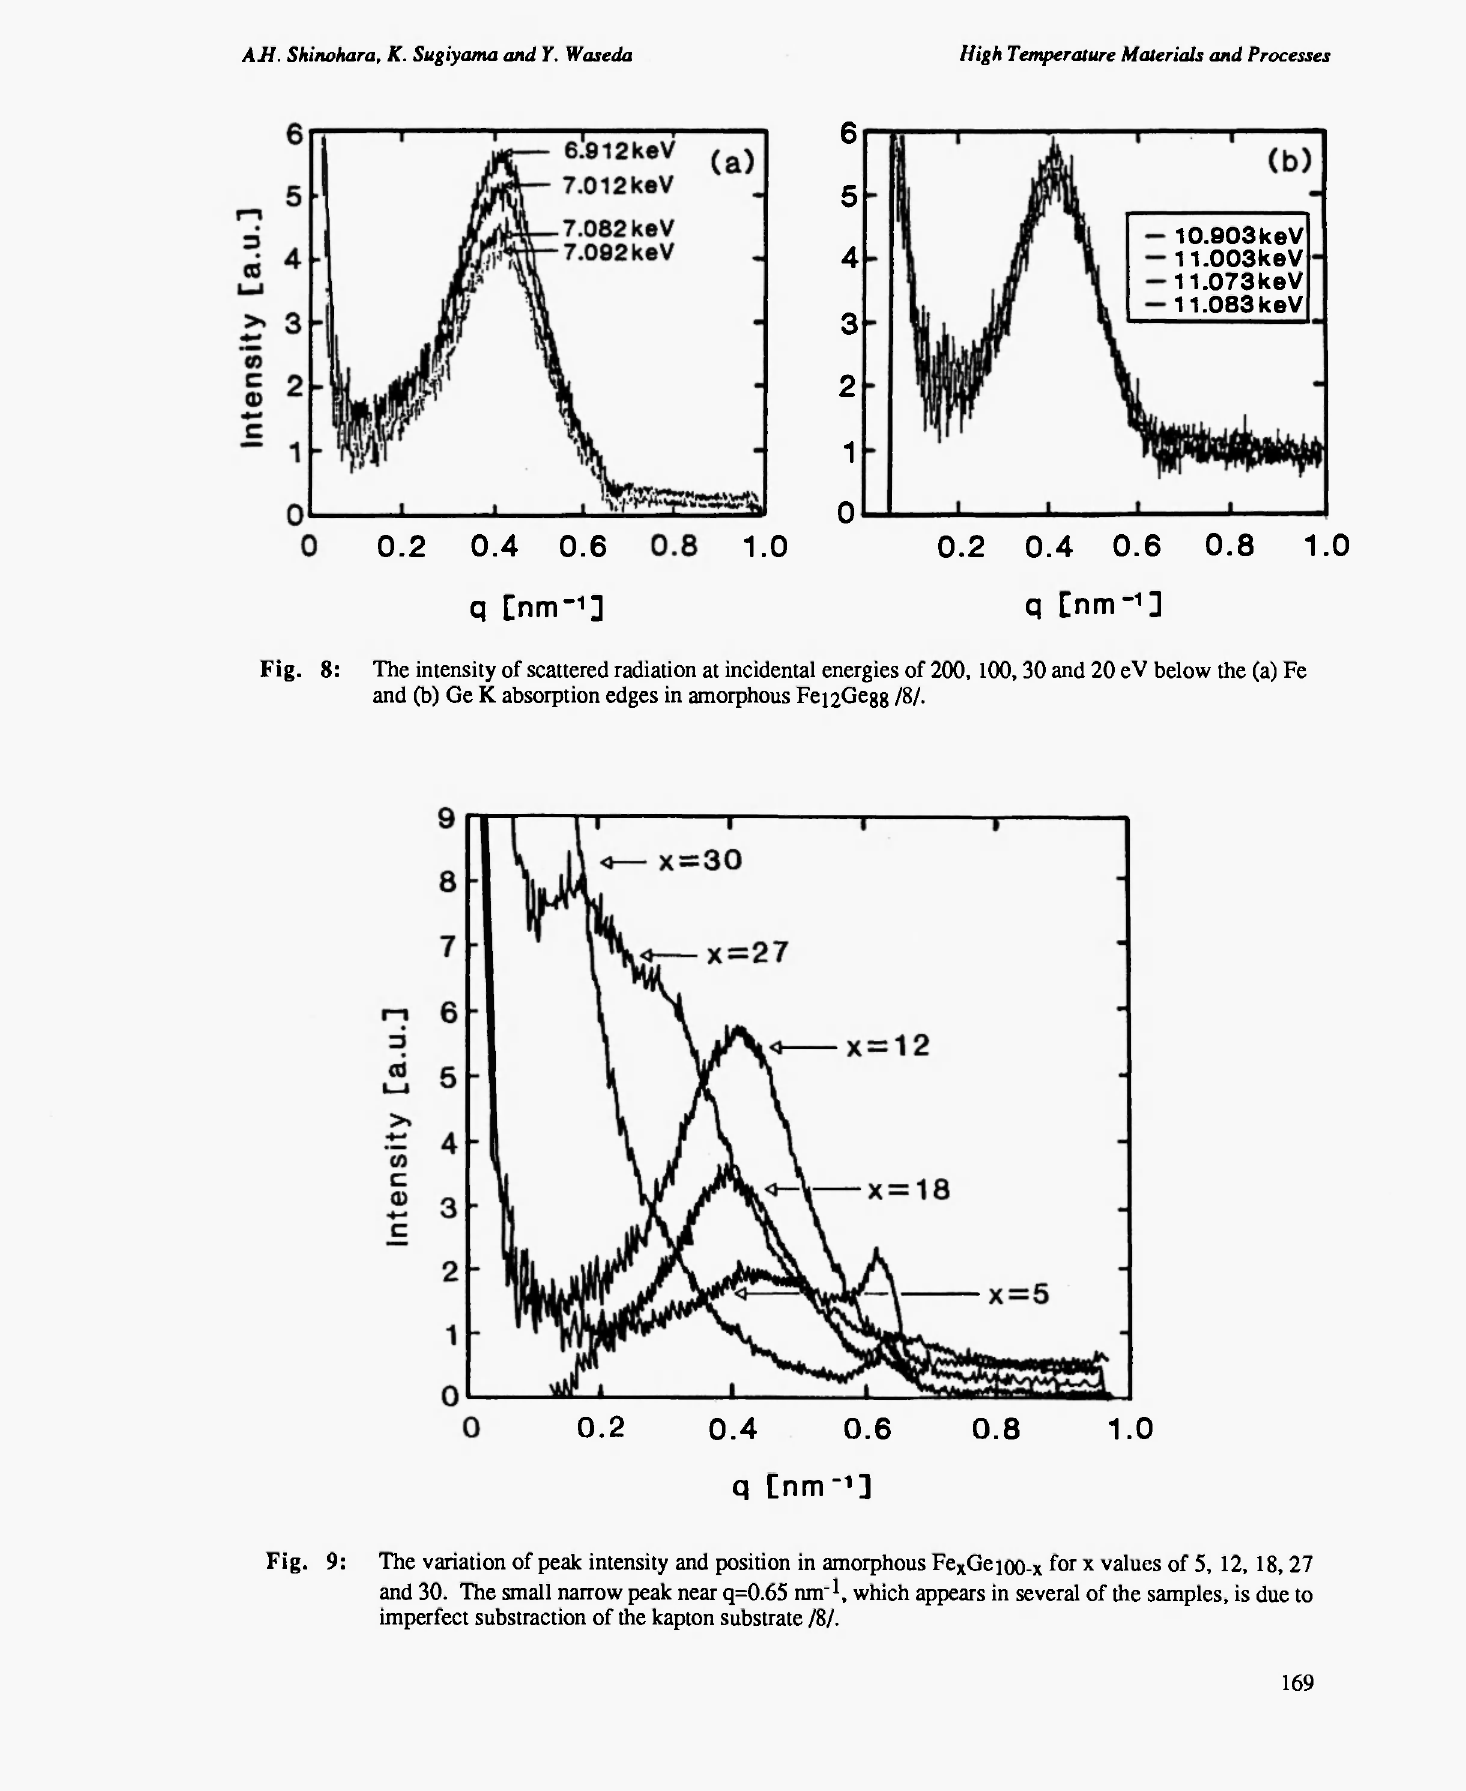
Fig. 9: The variation of peak intensity and position in amorphous Fe x Gei00-x for χ values of 5, 12, 18, 27 and 30. The small narrow peak near q=0.65 nm" 1 , which appears in several of the samples, is due to imperfect substraction of the kapton substrate